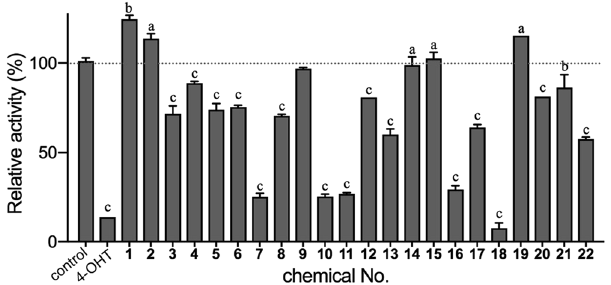
Figure 3. Antagonist activity of 4-OHT and BPA-related compounds according to luciferase-reporter assay. Antagonistic activities by the compounds are indicated as transcriptional activity relative to the luciferase activity induced by 10 nM E2 in the absence of a compound (indicated as control). One-way analysis of variance was performed to analyse significant inhibition of E2-induced activity relative to the activity observed in the absence of the compounds (control). * p < 0.001; ** p <